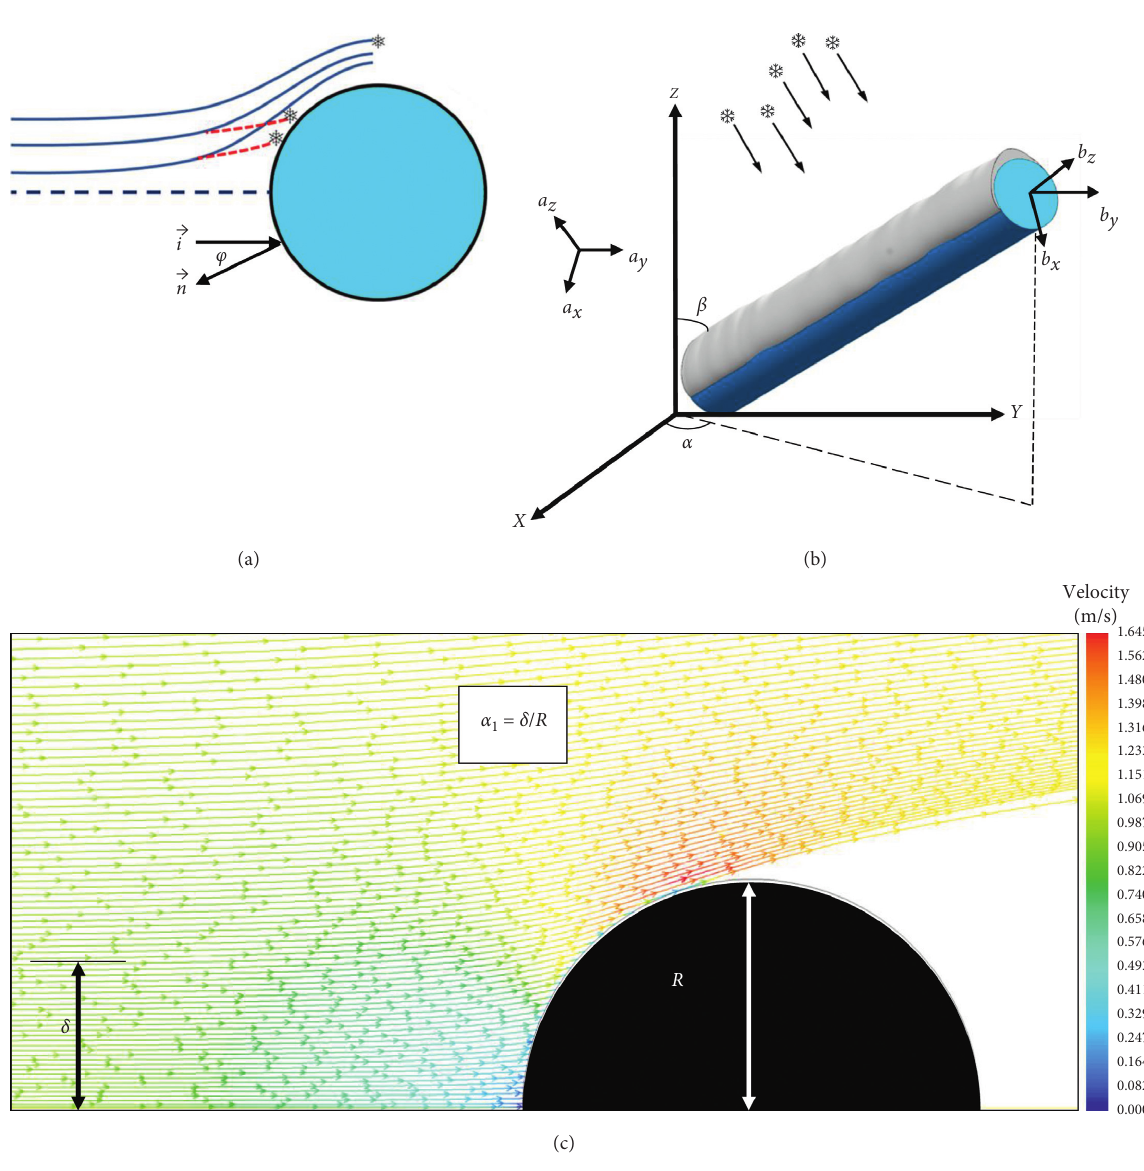
Figure 1: (a) Schematic of the snow particles in a flow around a cross section of circular cable stays. Geometry of the object, velocity, size, and shape of the snow particles are the determining factors of the route that the particles pass. (b) Schematic of snow accumulation on inclined cylindrical cable stays. A matrix is used to transform the z direction (gravity direction) to centerline for modelling wet snow accumulation on torsionally rigid inclined cable stays. (c) The snow particle’s velocity field for cable diameter ( D � 20cm), diameter of snow particles ( d p � 1mm), and density of snow particles ( ρ p � 170kg/m 3 ) with air inlet velocity ( | U